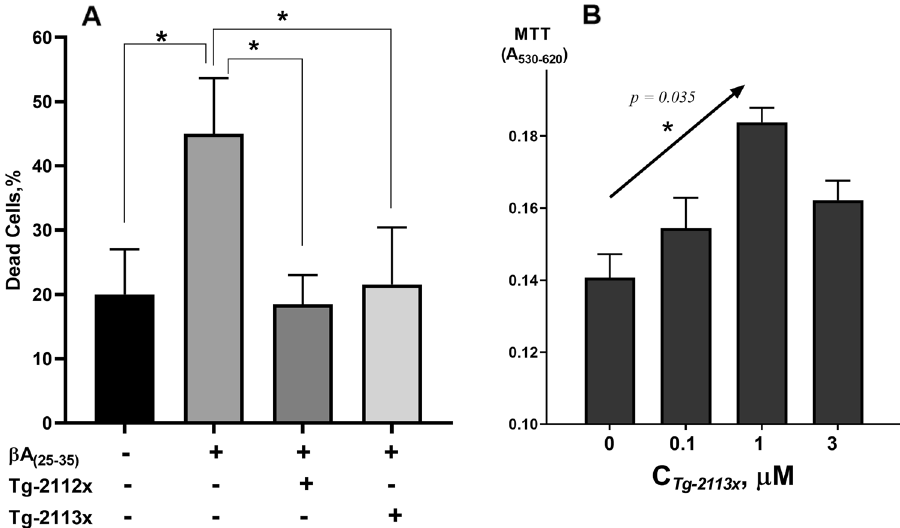
Figure 5. Tg-2112x and Tg-2113x protect cells against βA- and ionomycin-induced toxicity. ( A ) Tg-2112x and Tg-2113x reduced the percentage of βA (25–35) -induced cell death in co-cultures of neurons and